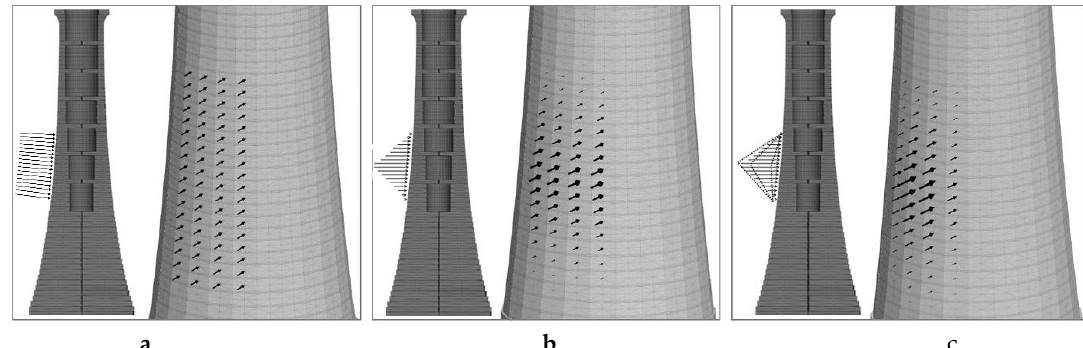
Figure 6. Wolf Rock lighthouse: ( a ) Wolf Rock lighthouse cross-section, 1964 (Trinity house archive [56]); ( b ) 3DEC model section; ( c ) model perspective view; and ( d ) detail of interlocking.